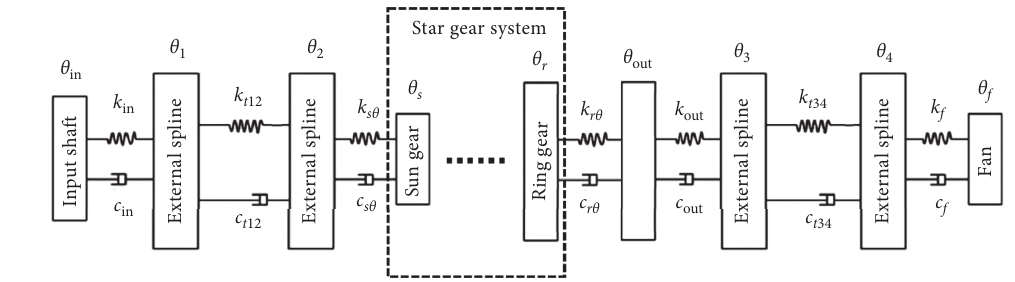
Figure 5: Dynamics model of transmission system of GTF